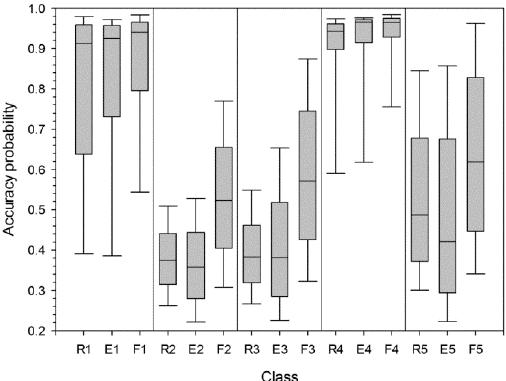
Figure 8. Box plots of accuracy probability values per class for different classification scenarios. R, E, and F on the x-axis stand for Radarsat-1, ENVISAT ASAR, and fusion, respectively. Numbers next to abbreviations indicate class codes (1: paddy fields, 2: dry fields, 3: forest, 4: water, 5: built-up).